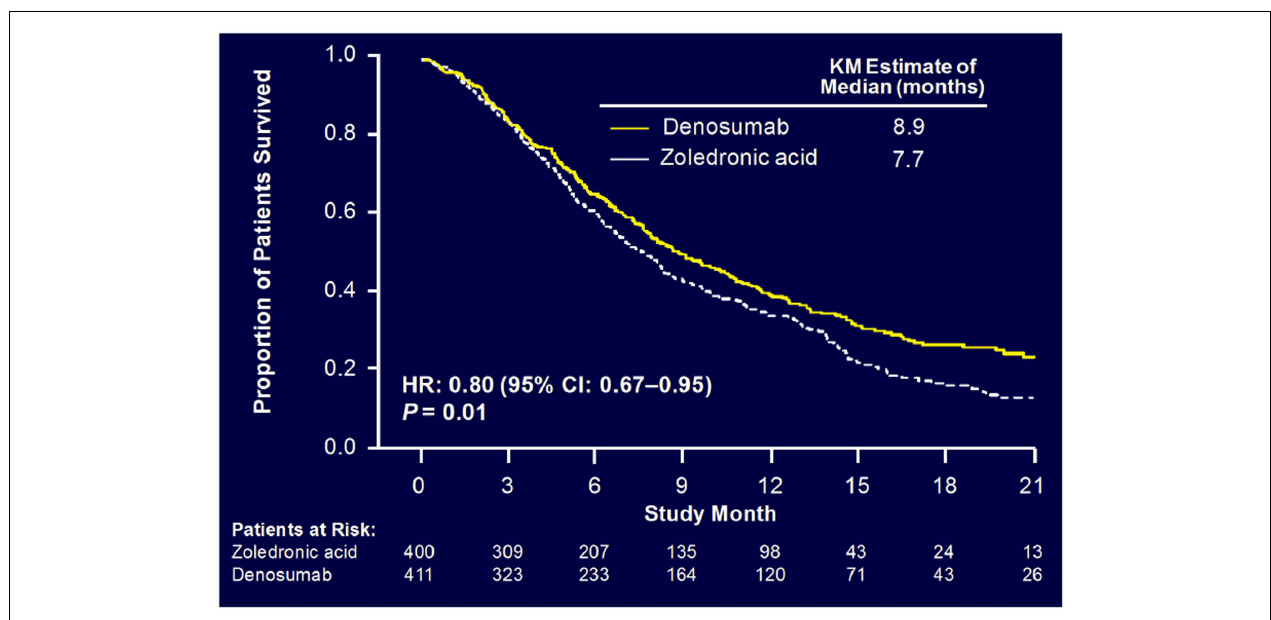
FIGURE 6 | Overall survival: patients with lung cancer .